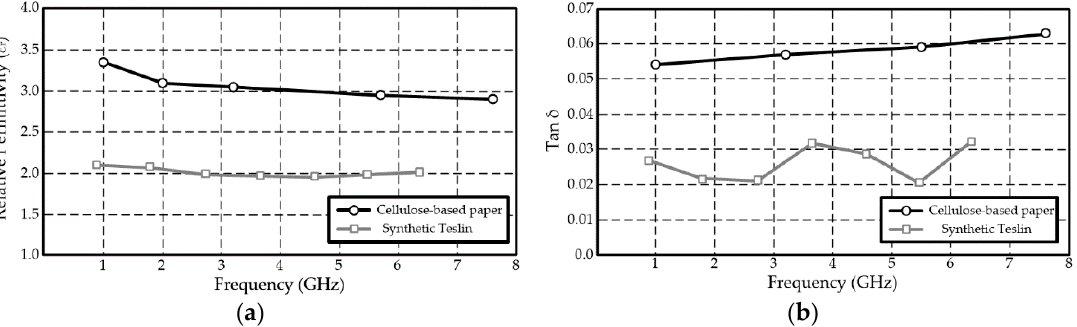
Figure 1. ( a ) Relative permittivity ( ε r ) of cellulose-based (black) and synthetic paper (gray) and ( b ) the loss tangent (tan δ ) of cellulose-based (black) and synthetic Teslin (gray).